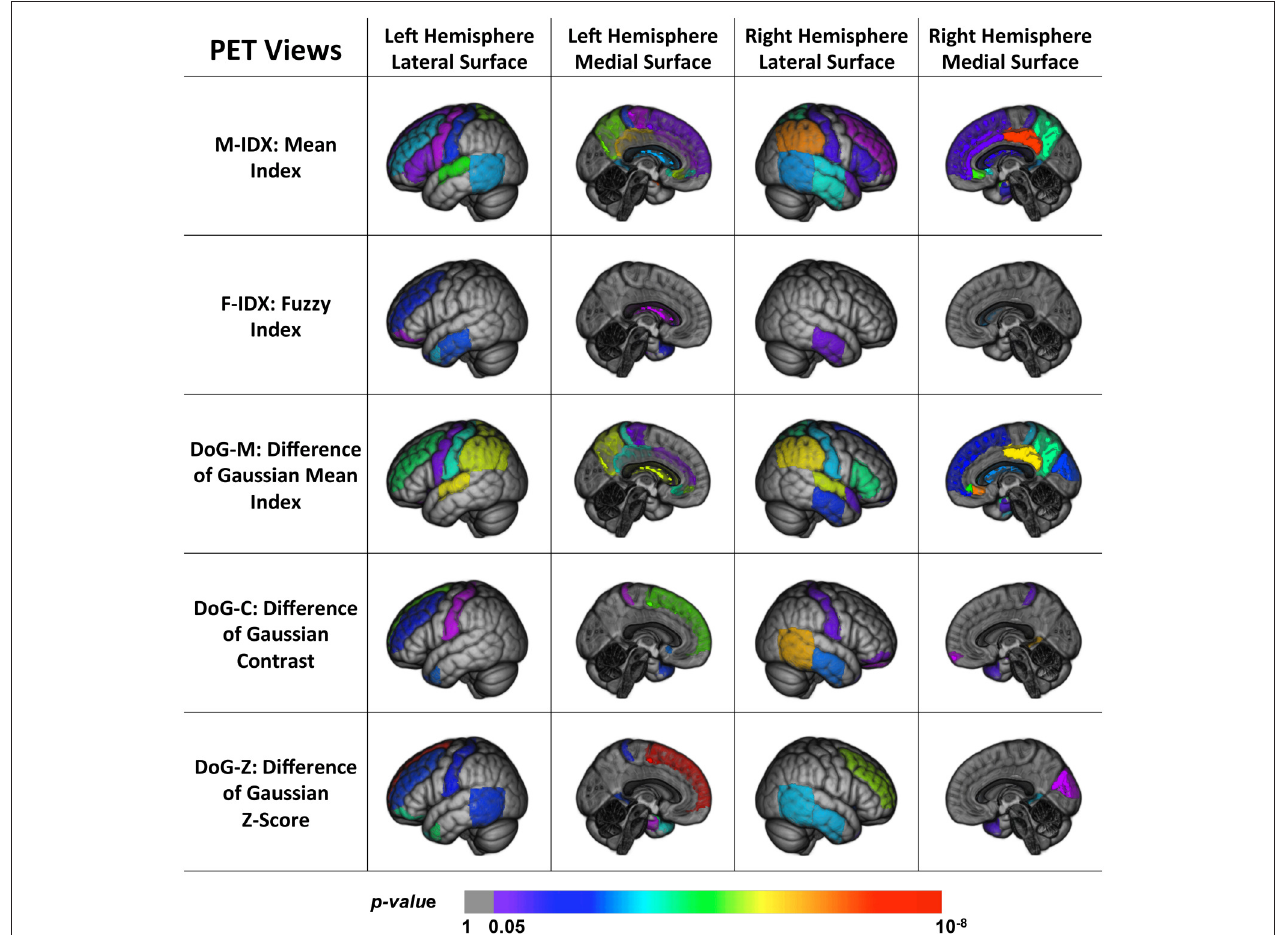
FIGURE 3 | Back projection of the normalized weights of the ROIs for five PET views onto the ICBM_152 template using 3D Slicer.